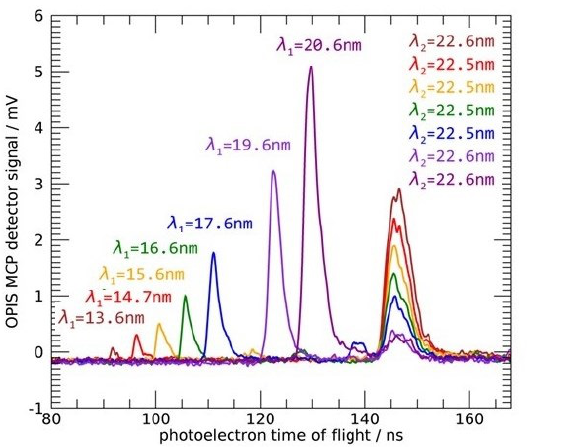
Figure 8. Two-color OPIS measurement while scanning color 1 from λ 1 = 13.6 nm to 20.6 nm. Color 2 was kept at λ 2 = 22.6 nm. The time of flight directly translates into photon beam wavelength. The OPIS was operated with argon as a target gas. The main features to which the wavelength labels are assigned to are the Ar 3p photoelectron lines. A retardation voltage of 25 V had been applied to the flight